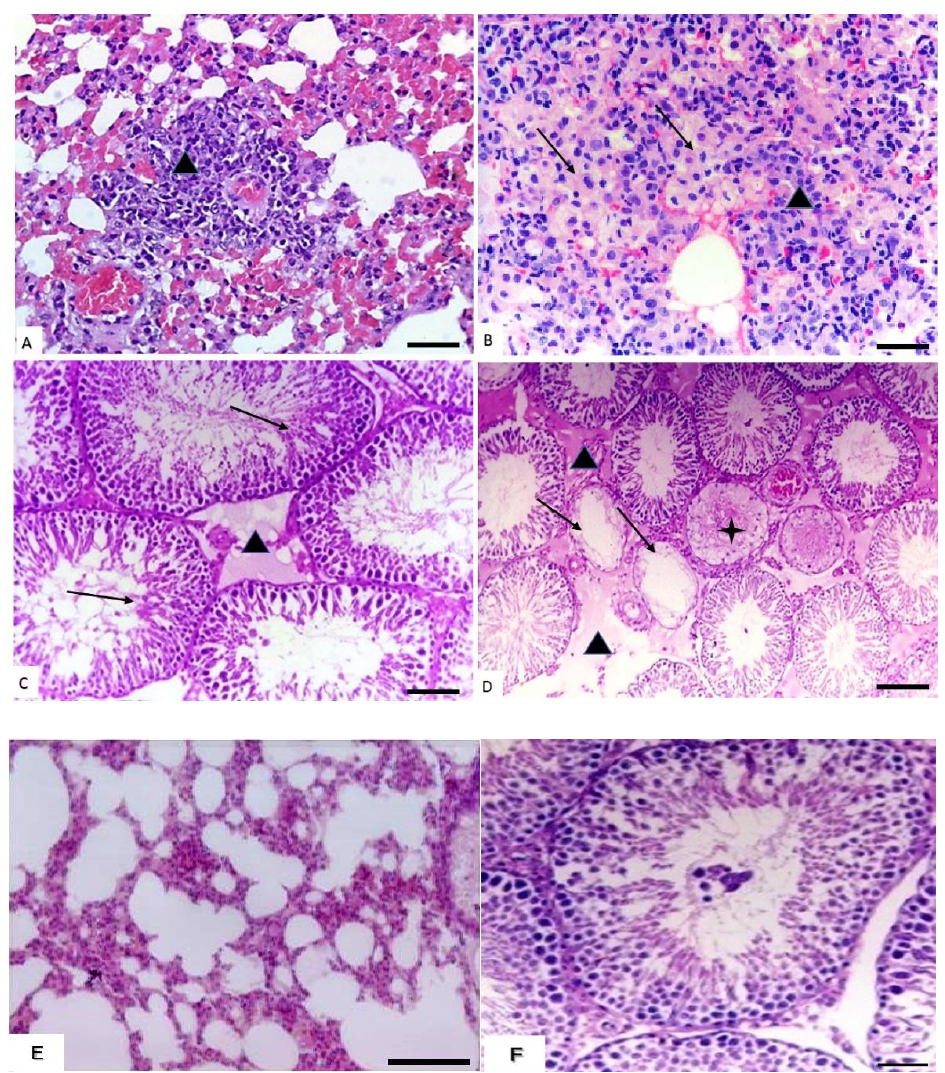
Figure 4. Effect of cymoxanil on the lungs and testis. ( A ) Lungs of rats treated with medium dose showing thickening of the inter-alveolar septa (triangle) (H&E, bar = 50 µm). ( B ) Lungs of rats treated with high dose showing massive interstitial pneumonia (triangle) with pneumocyte type II hyperplasia (arrows) (H&E, bar = 50 µm). ( C ) Testis of rats treated with medium dose showing decrease in the number of spermatogenic layers (triangle) with slight and focal interstitial oedema (star) (H&E, bar = 50 µm). ( D ) Testis of rats treated with high dose showing complete necrosis of the lining epithelium of some seminiferous tubules (triangle) and massive interstitial oedema (star) (H&E, bar = 100 µ m). ( E ) Lungs of control rats showing clear alveoli and small interalveolar septa (H&E, bar = 50 µ m). ( F ) Testis of control rats showing spermatogenic cells arranged in layers with mature spermatozoa (H&E, bar = 50 µ